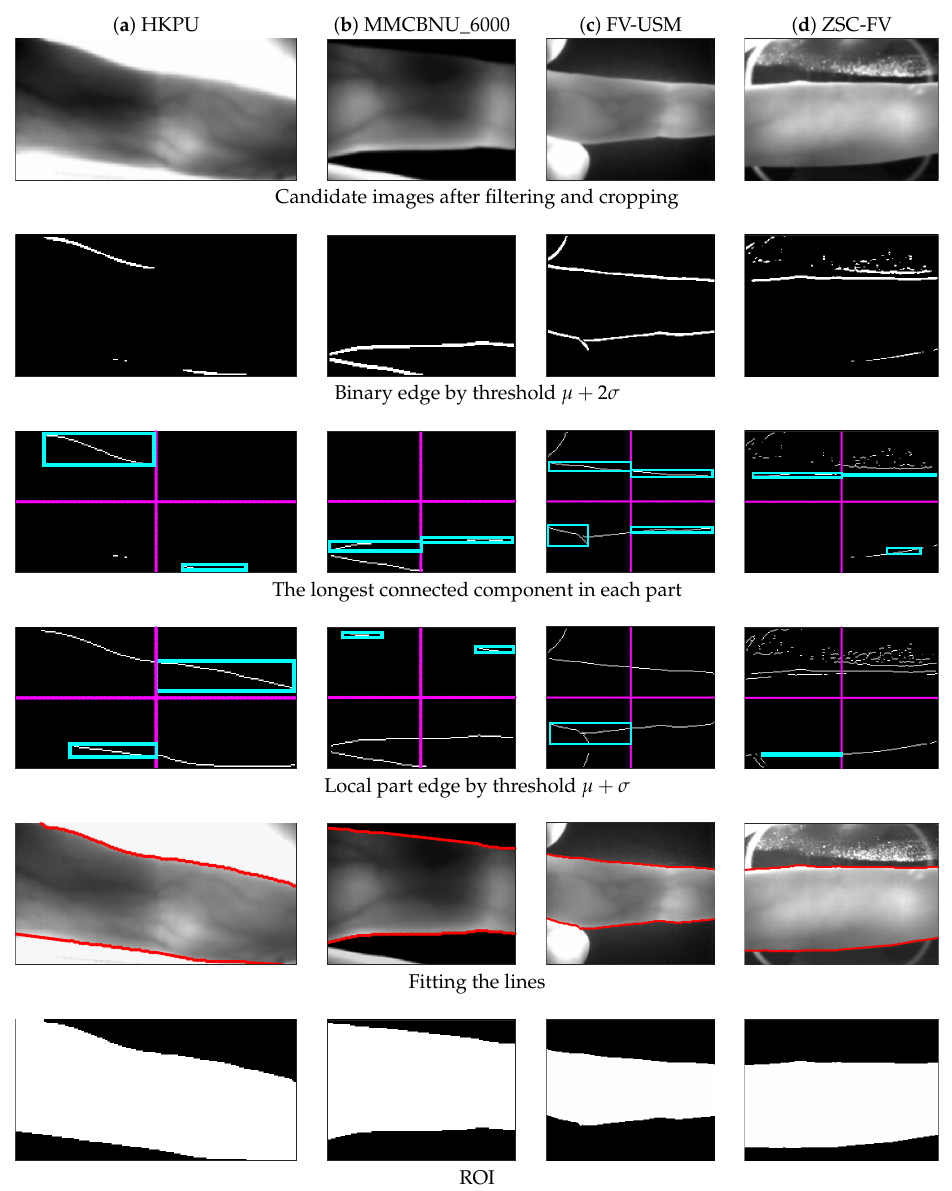
Figure 7. Processing results of some medium-quality images from the four datasets,